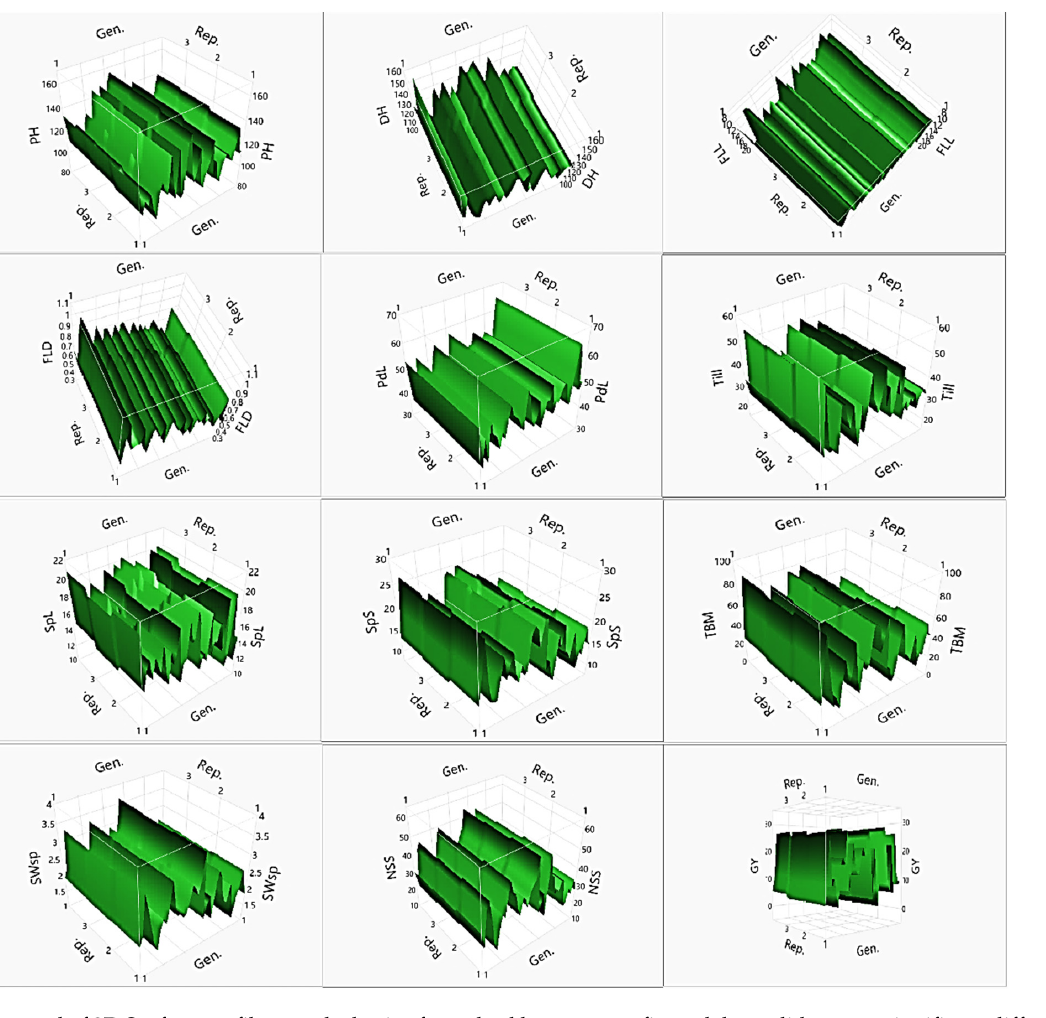
Figure 1. A panel of 3D Surface profilers on the basis of standard least-square fit model to validate non-significant differences among replications and significant differences among experimental wheat genotypes regarding studied morphological traits.